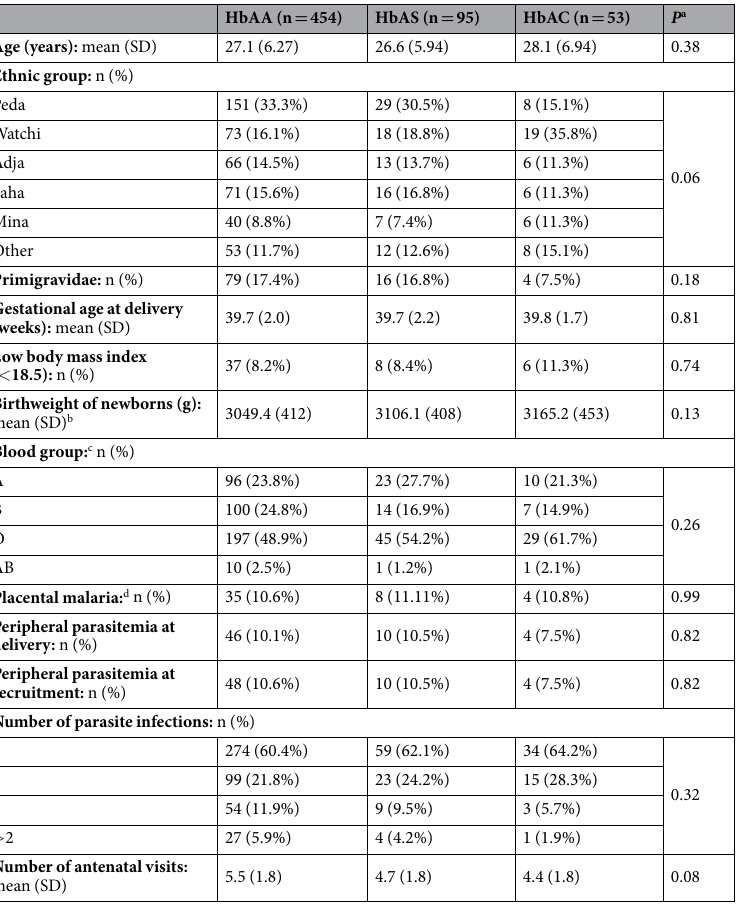
Table 1. Characteristics of pregnant women, according to HBB genotype. a P value of One Way Analysis of Variance for quantitative variables, and P value of Chi-square test for qualitative variables. In order for the Chi- square test to be considered valid, AB and B blood groups were combined, and 2 and > 2 numbers of parasite infections were combined. b Birthweights for 551 women with no premature births or stillbirths are excluded (417 HbAA, 88 HbAS,46 HbAC). c ABO blood group data were available for 533 women (403 HbAA, 83 HbAS, 47 HbAC). d Placental malaria data were available for 438 women (329 HbAA, 72 HbAS, 37